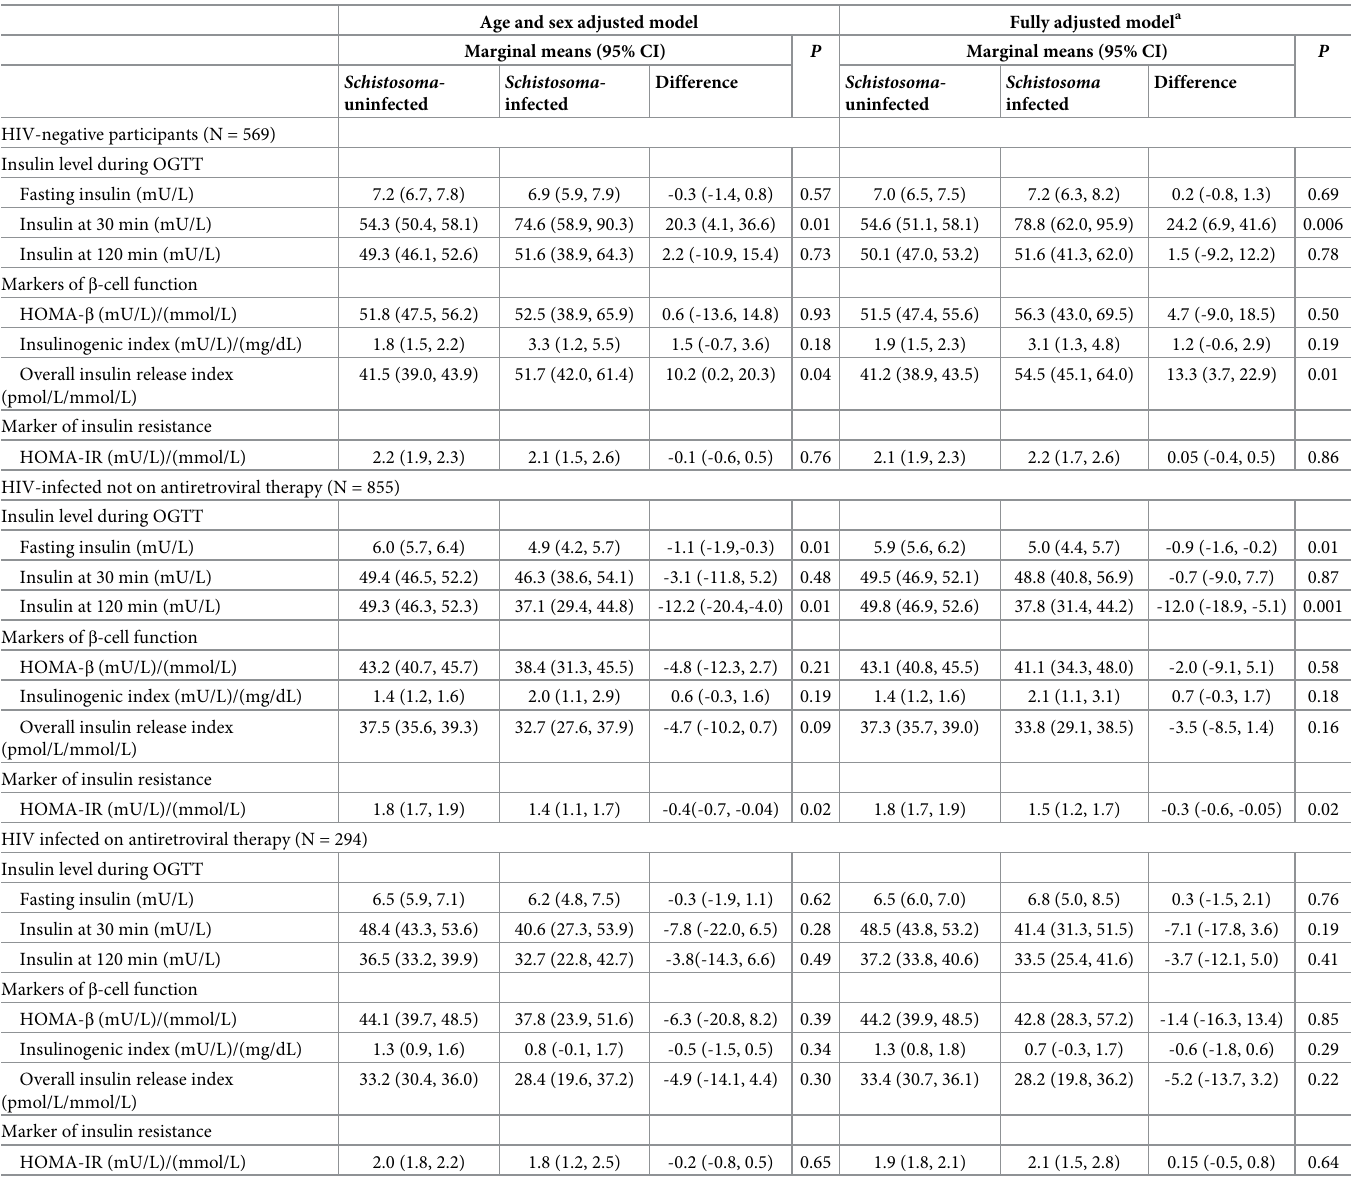
Table 2. Analysis of association of Schistosoma infection with β -cell function and insulin resistance by HIV treatment